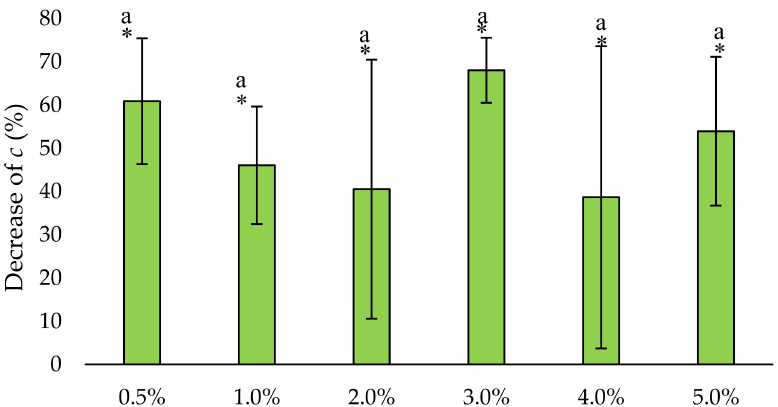
Figure 3. Water absorption ( c ) for samples containing the biocide in a concentration from 0.5% to 5% (differences to the control—samples without biocide). Statistically significant differences from the controls are marked with an asterisk. Statistically significant differences between the variants are marked with separate